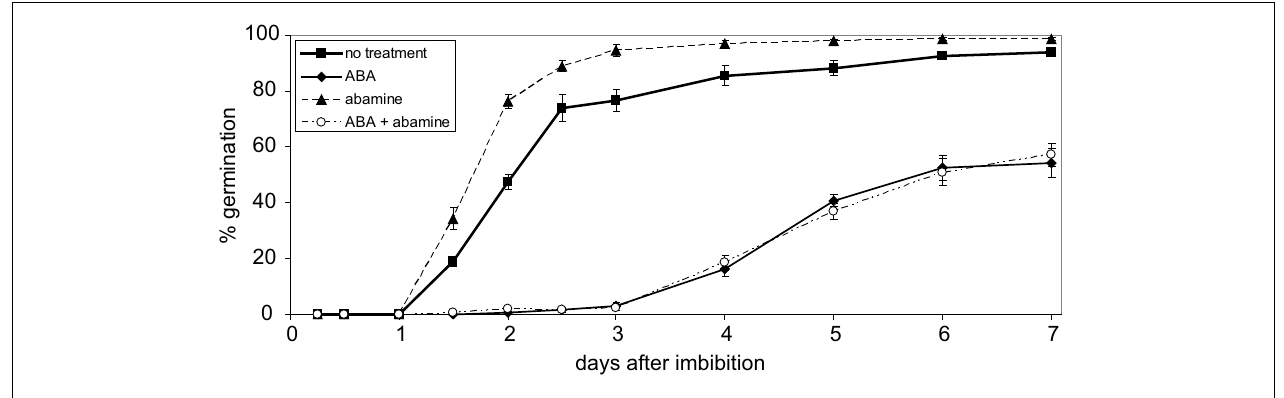
ABA + 50 µ M abamine, respectively. Germination rates were determined in the period from 1 to 7days after imbibition.Values are the means ± SEM obtained from five independent experiments (20–50 seeds